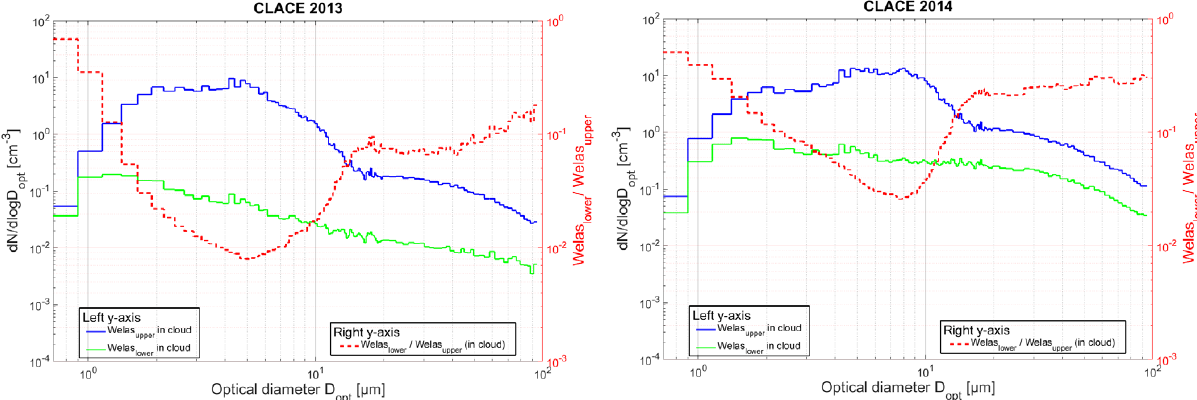
Figure 13. Averaged WELAS size distributions measured in cloud during CLACE 2013 (left panel) and CLACE 2014 (right panel) upstream and downstream of the droplet evaporation unit. The upper WELAS size distribution is given by the blue line, lower WELAS size distribution by the green line and the ratio of lower WELAS to upper WELAS size distributions by the dashed red line.